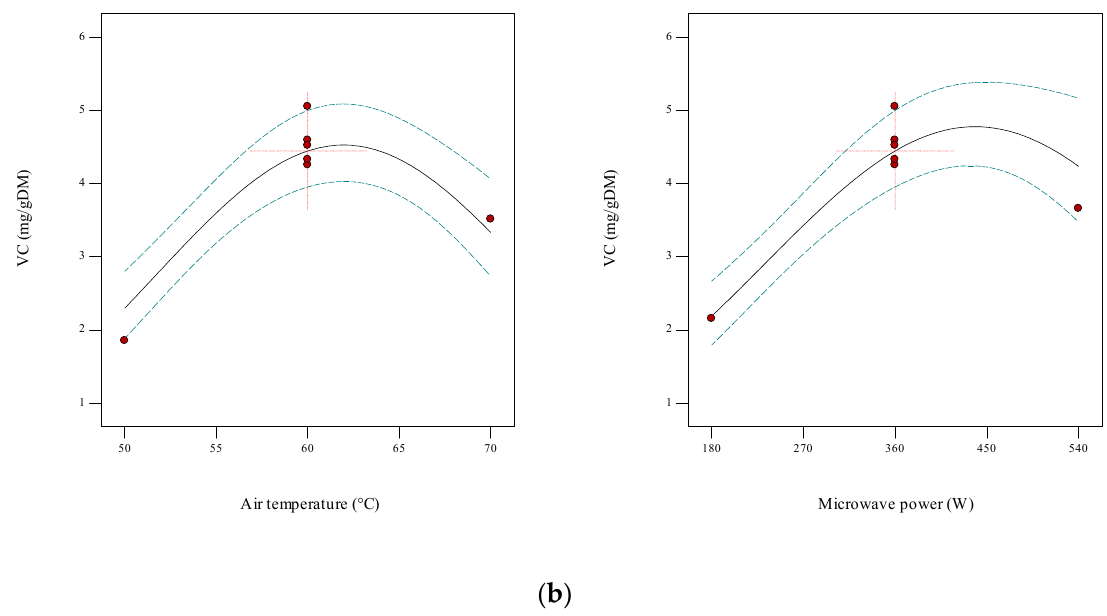
Figure 9. ( a ) The combined effect of air temperature and microwave power on vitamin C. ( b ) The individual effects of air temperature and microwave power on vitamin C.